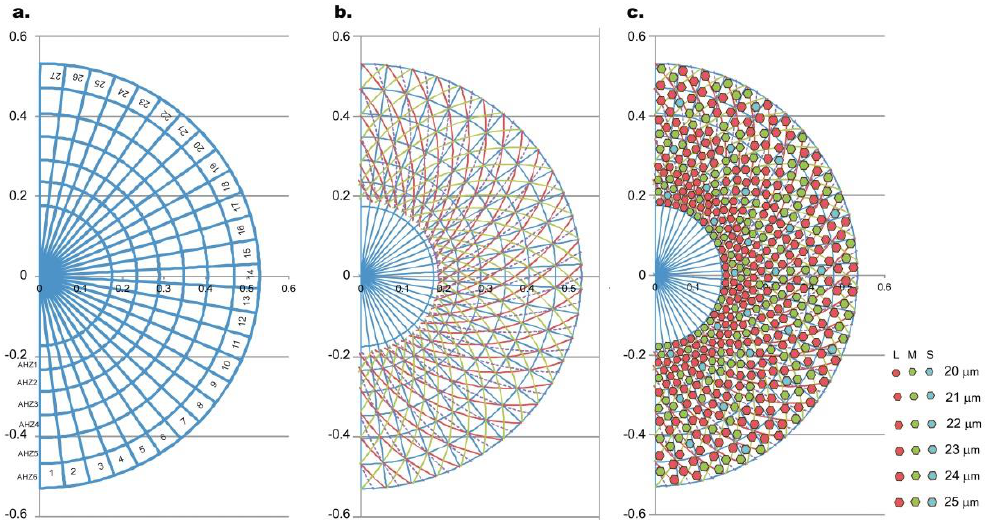
Figure 6. Packing arrangement of color pixels for 2 × 3 panel board ( a ) The lattice obtained by the planar projection of the superposition of the 27 circular surfaces on the first 6 annular hyperbolic zones (AHZs) resulting in a configuration of 162 circular trapezoids. ( b ) Three types of geodesics obeying Equation (15) have been plotted on the circular trapezoid configurations: the continuous red and green lines ( c 0 = 0.223) passing through the trapezoidal corners (one pixel lies on each line) and the dotted purple line ( c 0 = 0.127) on which lies the third pixel inside the trapezoid as explained in the text. ( c ) The final projection of 2 × 3 panels into various AHZs. This plot has been obtained in Microsoft Excel 2010 by a routine implementing the method described in the text. S, M and L cone cell sensitivity is represented by the corresponding colors: red (620–750 nm), green (500–570 nm) and blue (450–500 nm), respectively.